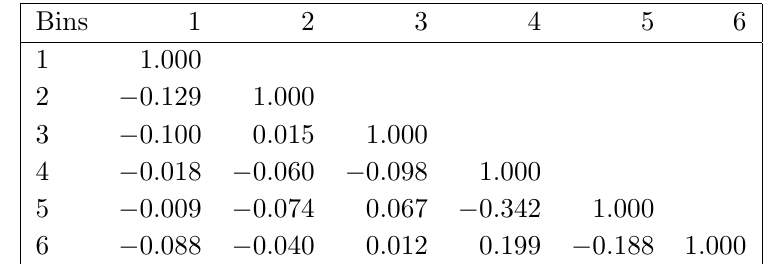
Figure 5 . The combined ATLAS+CMS charge asymmetry in six bins of the invariant mass of the tt system in comparison with theoretical predictions for the SM [19, 23] and two versions of a colour-octet model [68]. The last bin includes the over(cid:13)ow, both for the combination and the theory predictions. The uncertainties, indicated by the shaded areas, reported for the SM predictions are dominated by scale variations and are small, while the uncertainties reported for the colour-octet model are statistical uncertainties in the simulation.